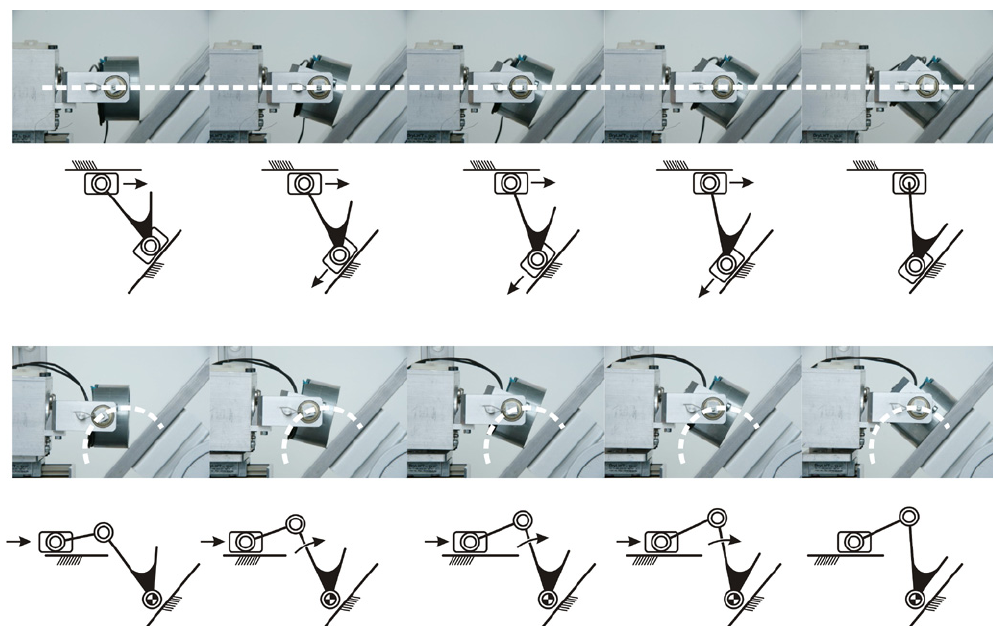
Figure 9. Comparison of linear and circular grasp